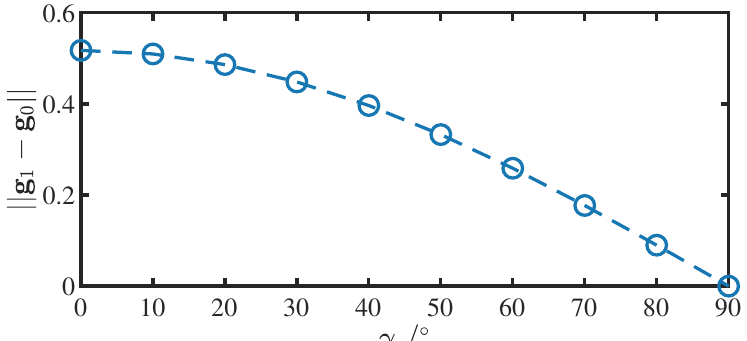
Figure 12. Relationship between the variation of β (angle between the rotational axis and the horizontal plane) and || g 1 − g 0 || ( 1 g = 9.8 m/s 2 )